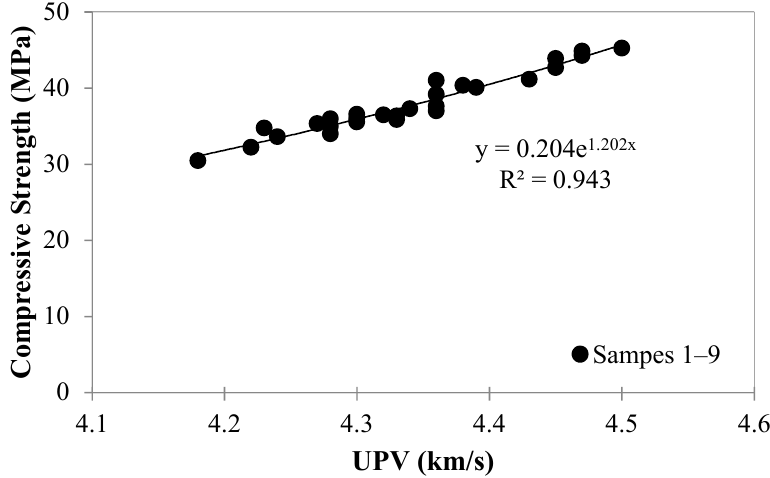
Figure 2. UPV (longitudinal) vs. compressive strength.